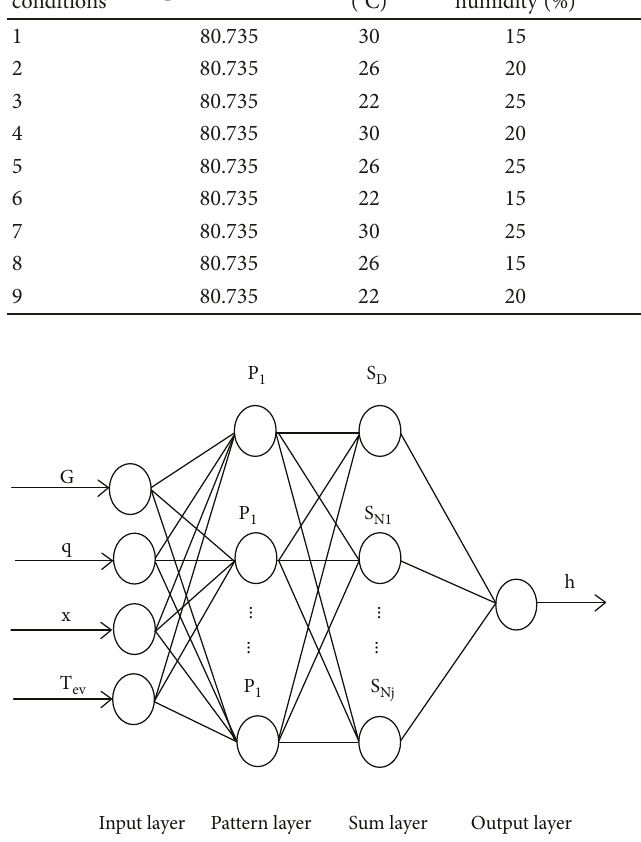
Figure 1: Flow boiling heat transfer GRNN network model structure